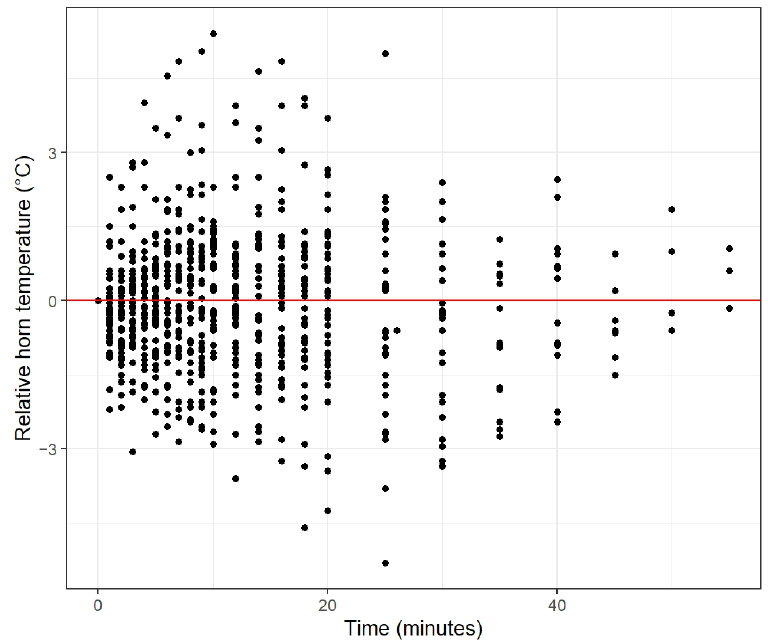
Table 4. Model fit (AIC) and p -values of the linear mixed-effects model testing horn temperature during the 20 min rumination bouts ( n = 41 cows).